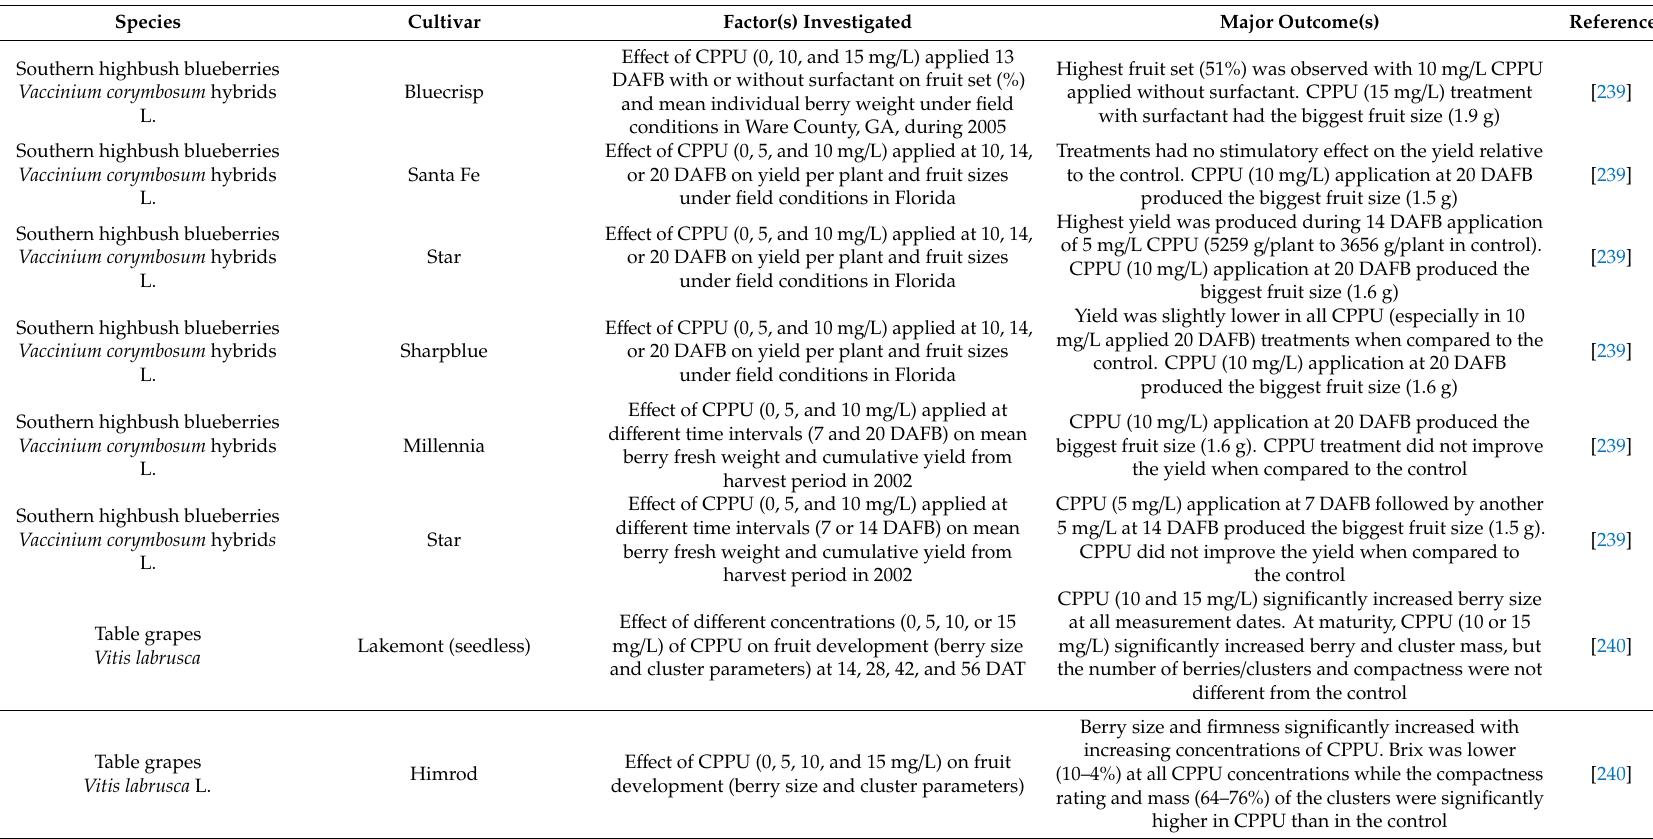
Table grapes Vitis labrusca